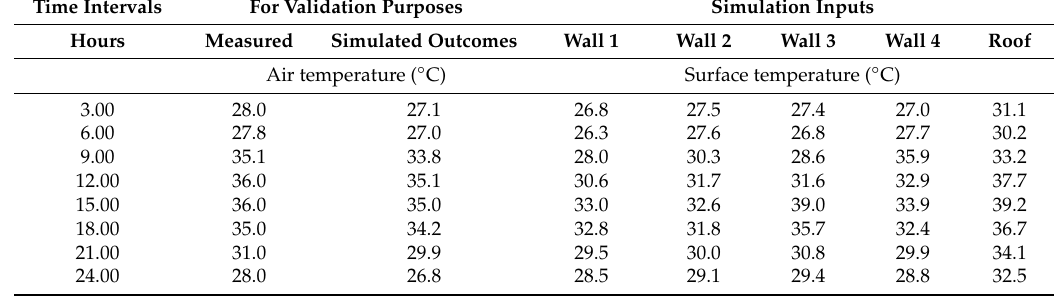
Table 4. Validation of air temperature taken at the middle of the alley in addition to model input of surface temperatures.